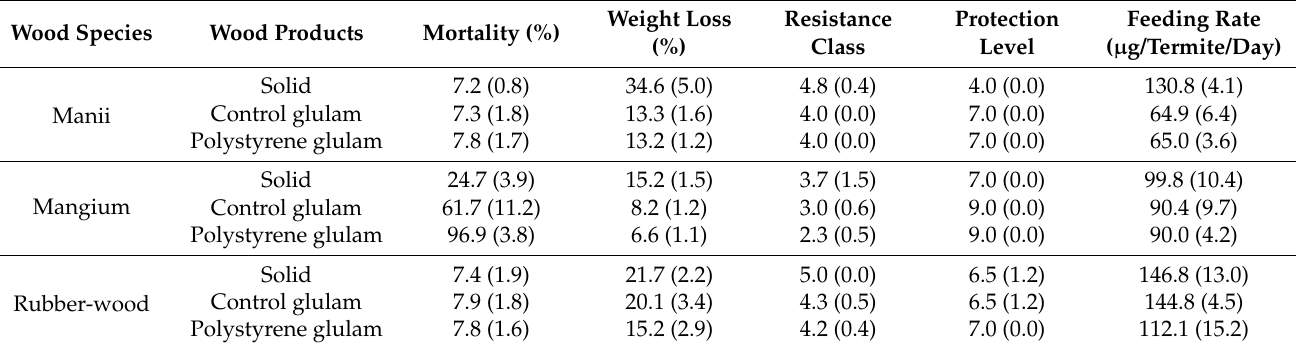
Table 6. Weight loss, resistance class, attack degree, mortality, and feeding rate of laboratory test.